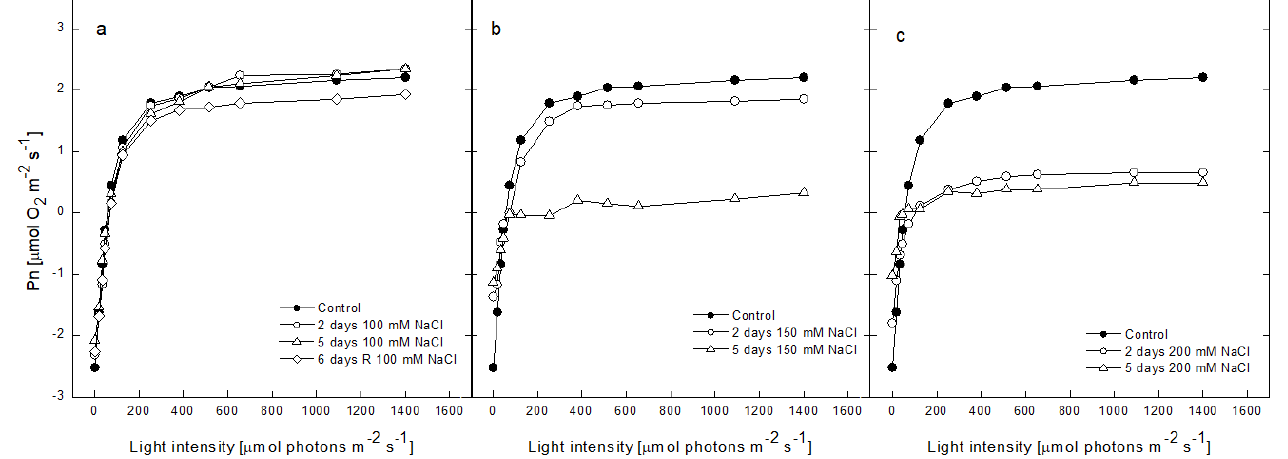
Figure 4. Light response curves of the photosynthetic oxygen evolution of 8 leaf discs of the pea plants, including the control (0 mM NaCl) and those treated with 100, 150 and 200 mM NaCl for 2 and 5 days and after recovery (6 days R) on pure Hoagland’s solution. Measurements were performed at room temperature (22 °C) and in a CO 2 -saturated atmosphere, with increasing light intensities (0–1400 µmol photons m − 2 s − 1 ) provided by an LED source (>650 nm). Every curve is the average from 3 independent experiments with 2 parallel samples ( n = 6): ( a )–control plants (Control), treated with 100 mM NaCl for 2 and 5 days and after recovery (6 days R), ( b )–control plants (Control), treated with 150 mM NaCl for 2 and 5 days and after recovery (6 days R), and ( c )–control plants (Control), treated with 200 mM NaCl for 2 and 5 days.